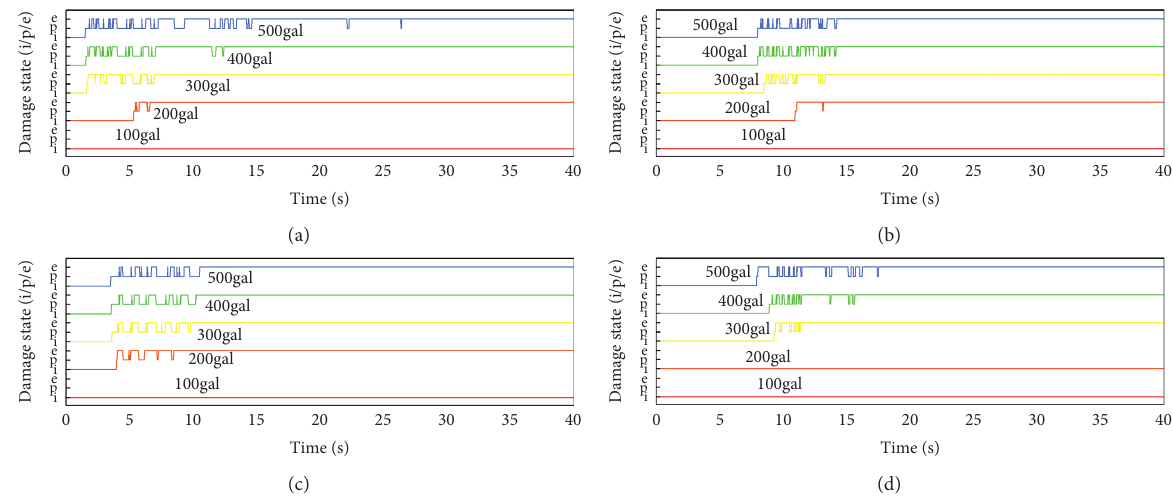
Figure 10: Time history of the damage state. (a) El Centro. (b) Kobe. (c) Northridge. (d) Parkfield.